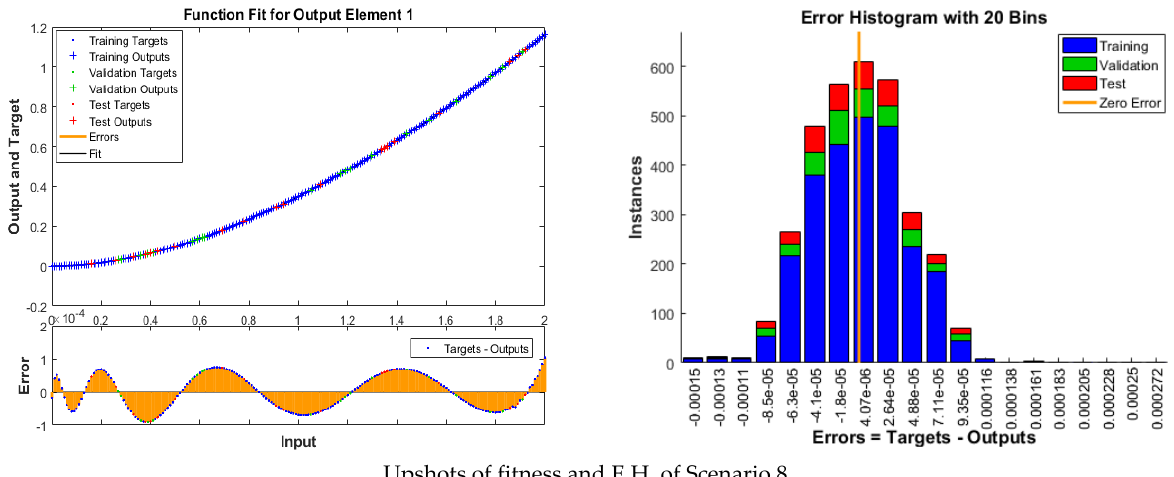
Figure 9. Solution of fitness and error histogram of proposed TLMB-NN for solving HTM-BFN model with MHD for Scenarios 7 and 8.